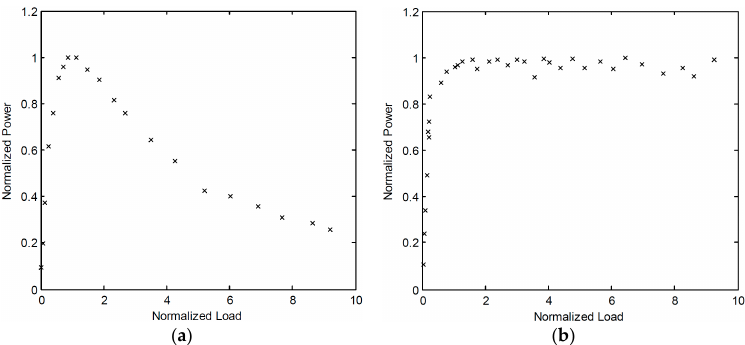
Figure 43. Normalized power obtained in experimental results for a PEH with di ff erent attached loads without ( a ) and with ( b ) an adaptive power management circuitry